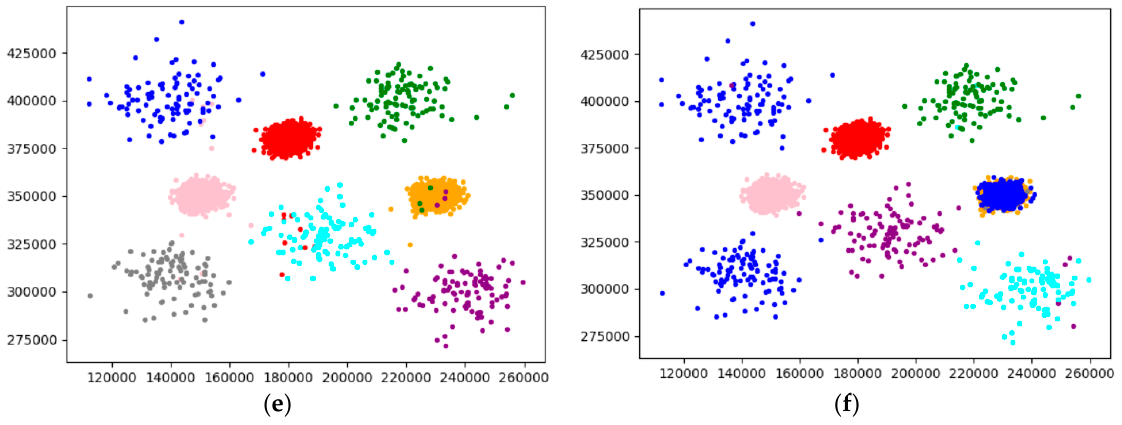
Figure 11. Visual analysis of Unbalance dataset [17,18] . ( a ) Original. ( b ) F-DPC. ( c ) DPC. ( d ) Reference [17]. ( e ) Reference [18]. ( f ) K-means. Experiment 3 uses a complex Compound dataset for comparison, where the Com- pound dataset has 399 samples and six cluster centers. The visualization results of each algorithm clustering are shown in Figure 12.